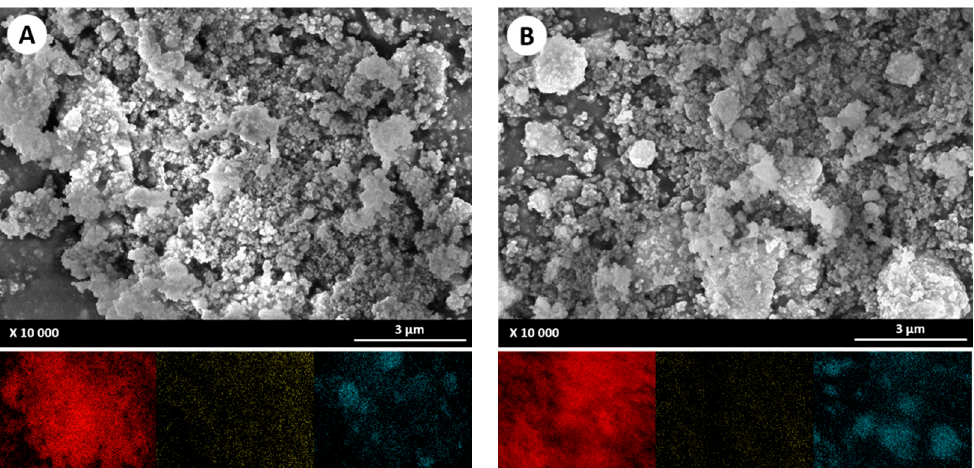
Figure 5. SEM views of the ( A ) Al/WO 3 /C suc and ( B ) Al/WO 3 /C cell mixtures. The elemental mapping analysis of the aluminium (red plot), carbon (yellow plot) and tungsten (blue plot) are reported for each diffused electron image.